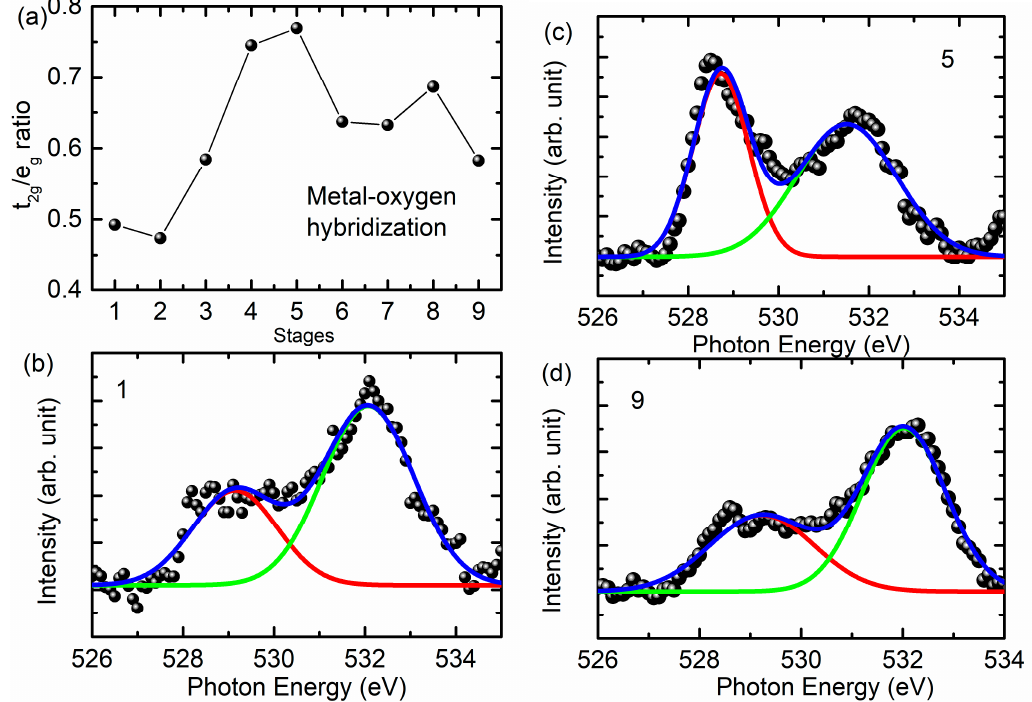
Figure 9. ( a ) The t 2g / e g ratio estimated from the pre-edge region of the O K -edge spectra at various charging and discharging stages. Here, ( b ), ( c ), and ( d ) show the representative de-convoluted spectra for the 1, 5, and 9 states.